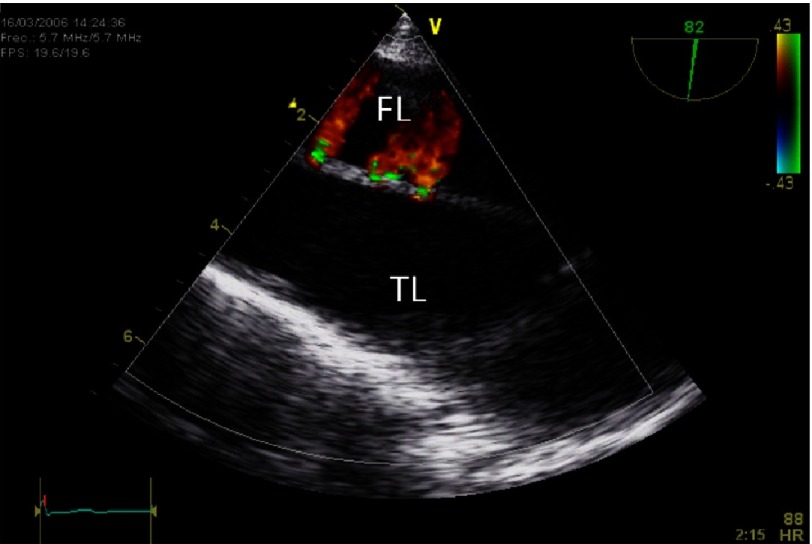
Transoesophageal echocardiography showing a type B AAD with secondary communications and small flows from true lumen (TL) to false lumen (FL).